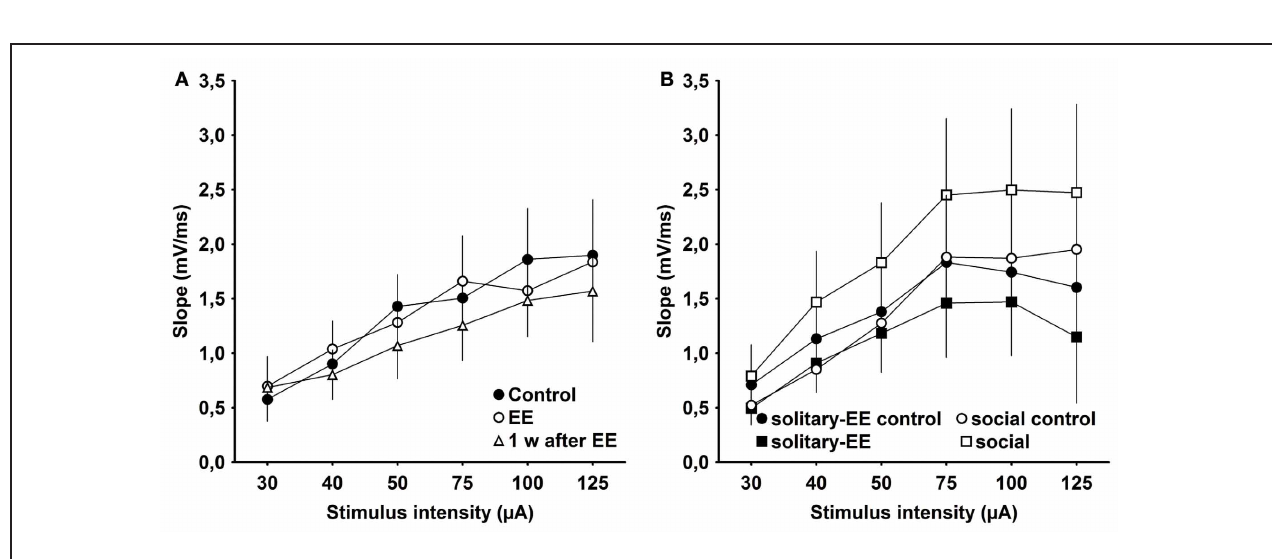
FIGURE 6 | Input–output analysis of evoked responses reveals no significant changes in excitability as a result of environmental enrichment. (A) Input/output (IO) properties remained stable between